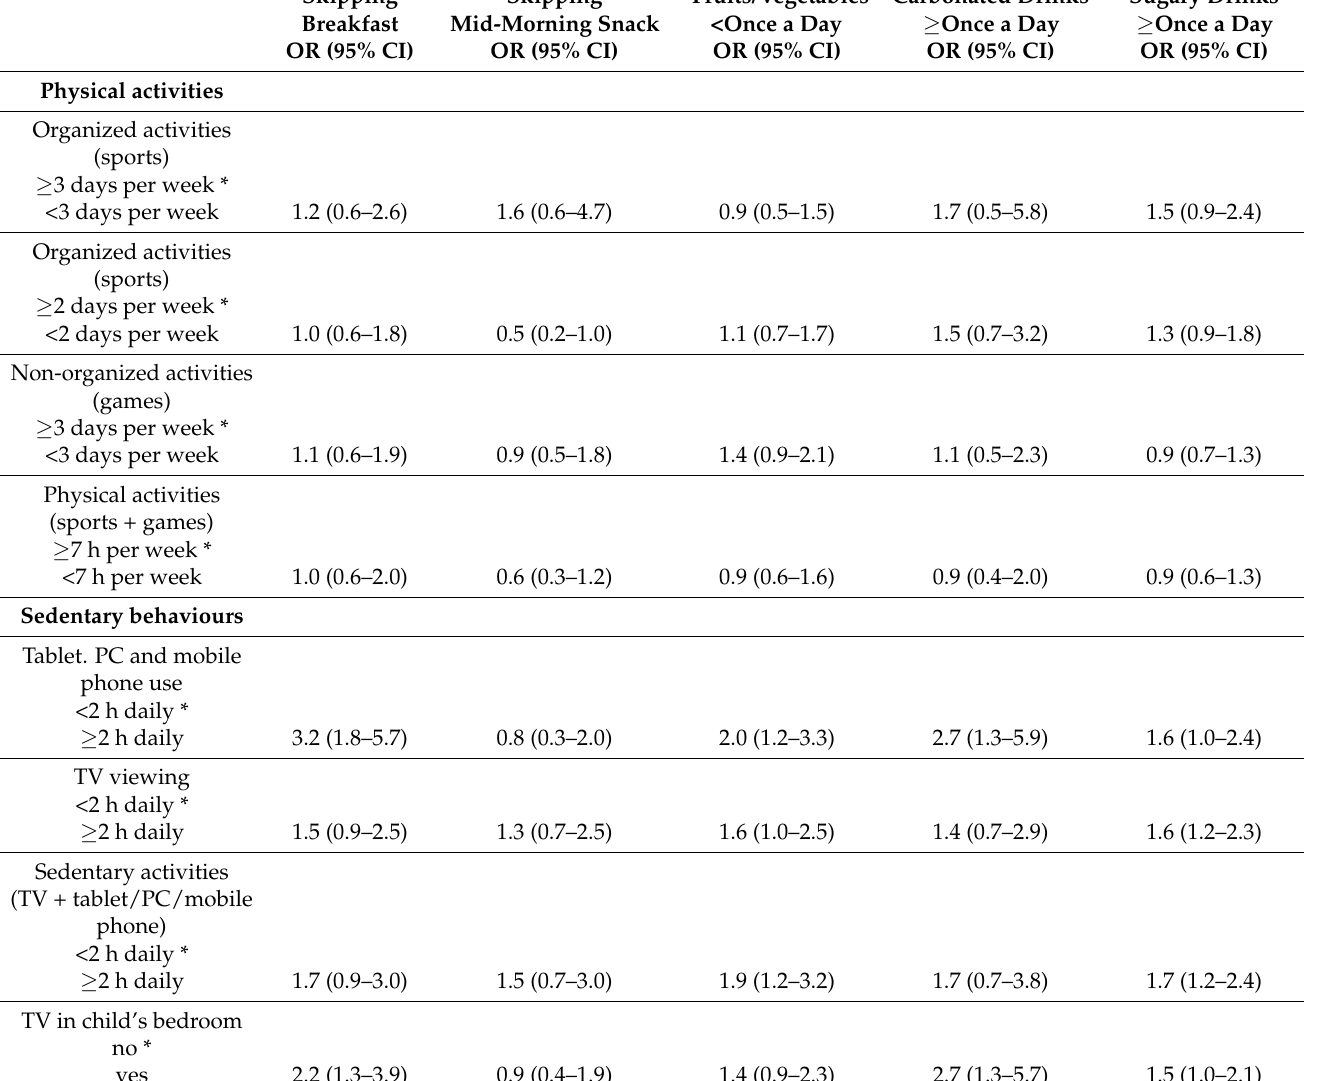
Table 5. Univariate logistic regression for dietary habits